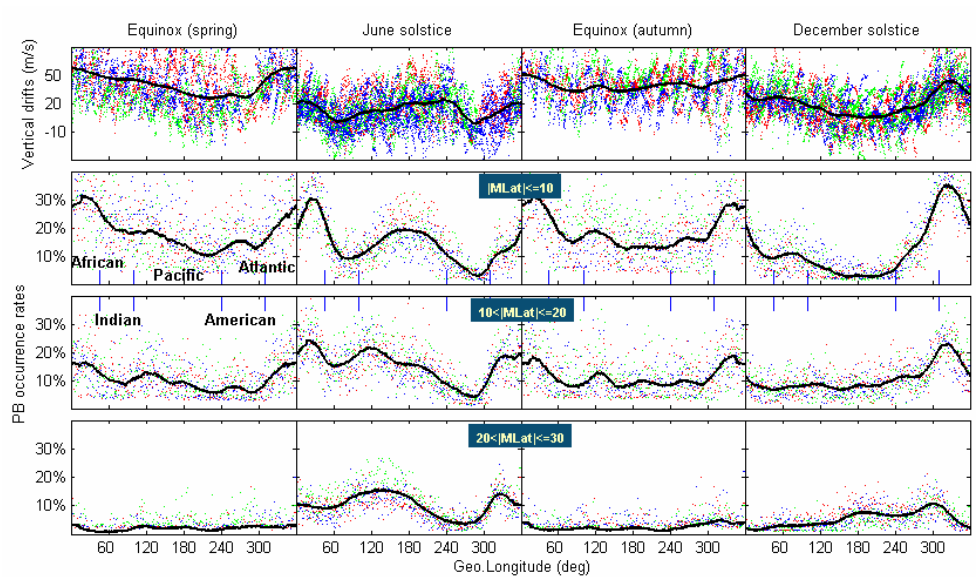
Figure 2. Seasonal and longitudinal variation of evening equatorial pre-reversal vertical drifts (top panels), and plasma bubble occurrence probability obtained from ROCSAT-1 during high solar activity periods (the middle and bottom panels represent plasma bubble occurrence probability within |MLat|<=10º, 10º<|MLat|<=20º and 20º<|MLat|<=30º; the scatterplot of red, green and blue points represent years 2000, 2001 and 2002 respectively).